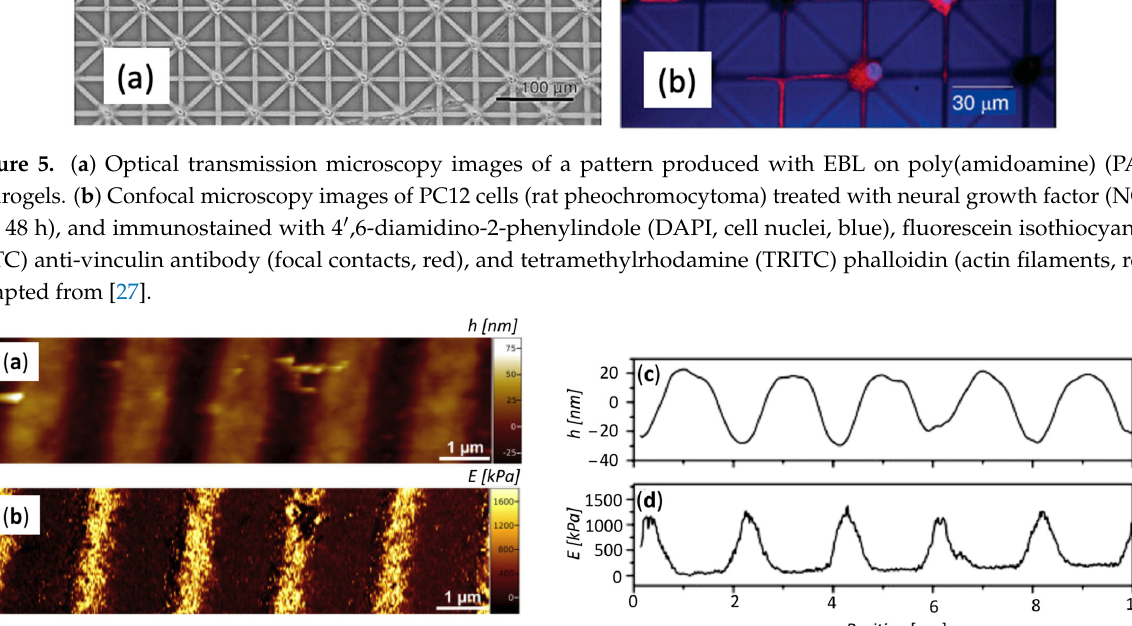
Figure 6. Two-step process to produce a mechanically patterned hydrogel coating, comprising EBL patterning of a dry gelatin film followed by global e-beam irradiation of the subsequently hydrated film. ( a ) AFM topographical image of patterned gelatin layer in the wet state after the two-step process. ( b ) AFM mechanical image showing local E-modulus. ( c , d ) Topographical and mechanical profiles of the stripe pattern after global irradiation in the wet state: ( c ) height and ( d ) E-modulus. Adapted from [45].